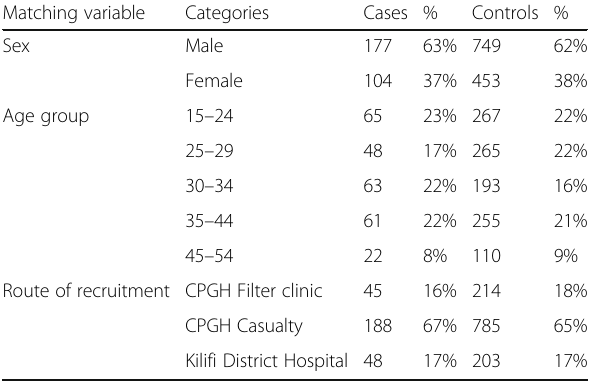
Table 2 Distribution of matching variables across cases and controls Matching